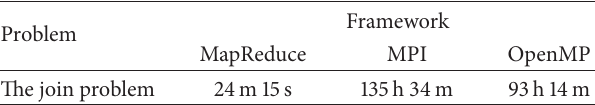
Table 2: Execution time for the join